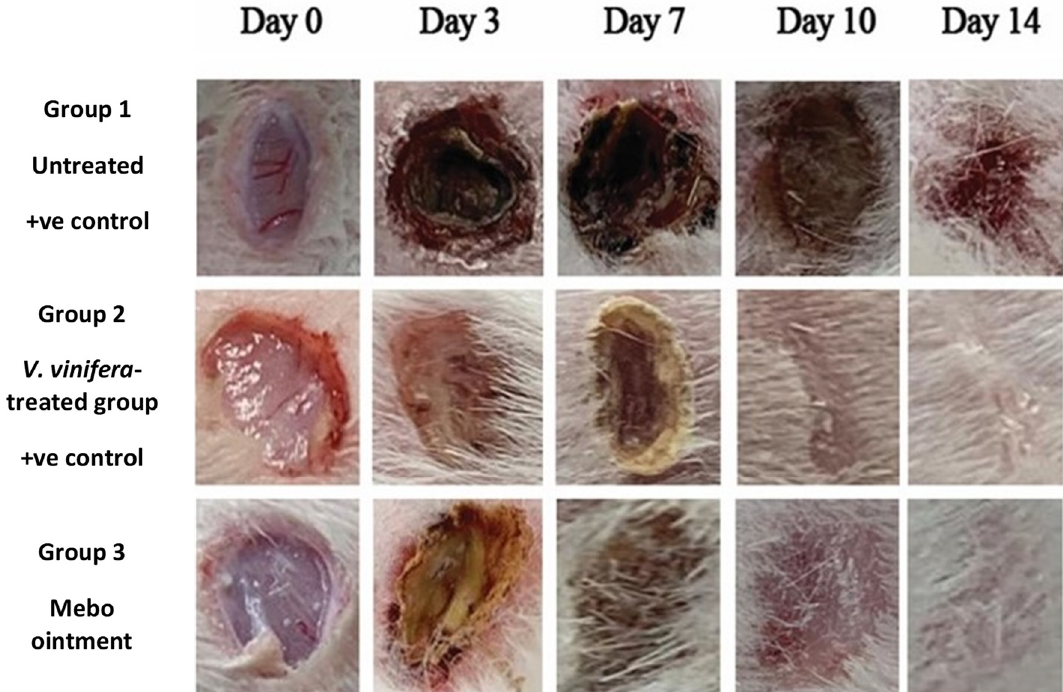
Figure 4. Wound closure rates in tested groups (group 1: Untreated group representing the control; group 2: V. vinifera seed-treated group; group 3: (MEBO ® -treated group) over time post-injury (0, 3, 7, 10, and 14 days). Significant difference among groups is evaluated by a two-way ANOVA test. Data were expressed as mean ± SD. p < 0.001 compared to those of the control group on the respective day and p < 0.001 compared with those of the Mebo ® group on the relevant day.